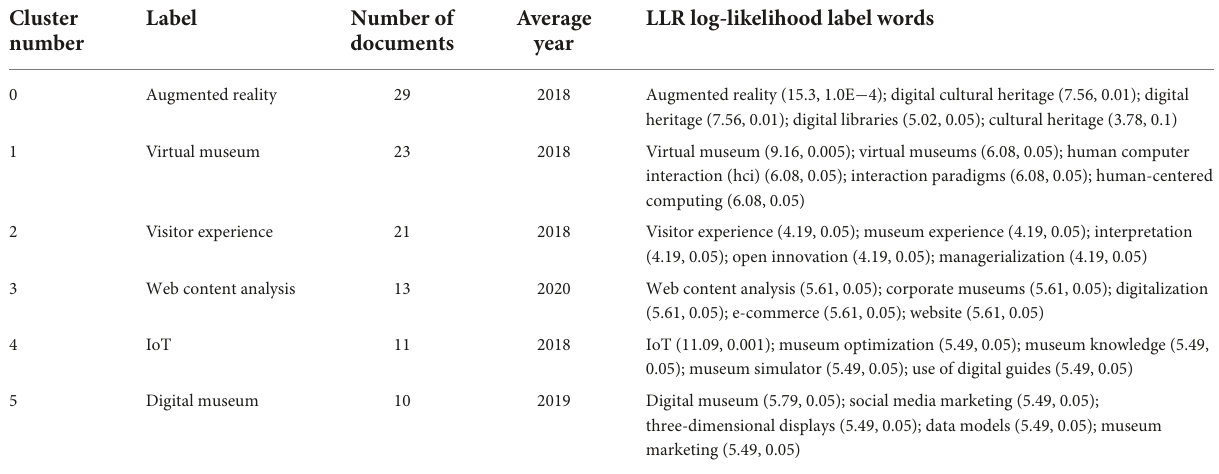
TABLE 1 Keyword clustering table of related research (the table information is processed by CiteSpace after our research team retrieves the information). Cluster Label Number of number